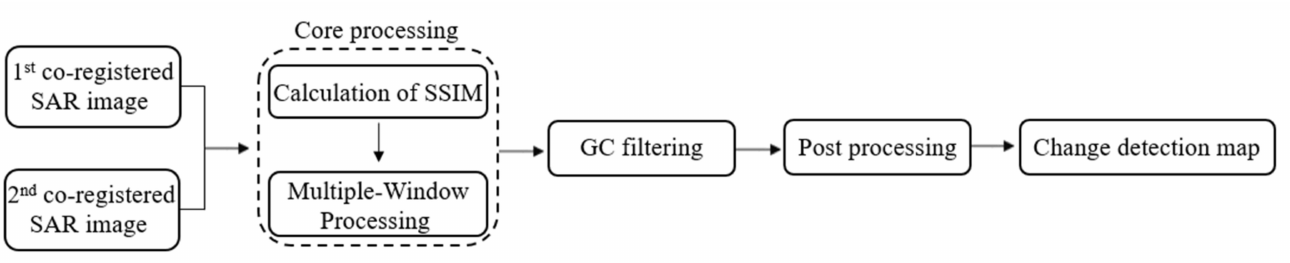
Figure 3. Detailed processing workflow that is proposed in this